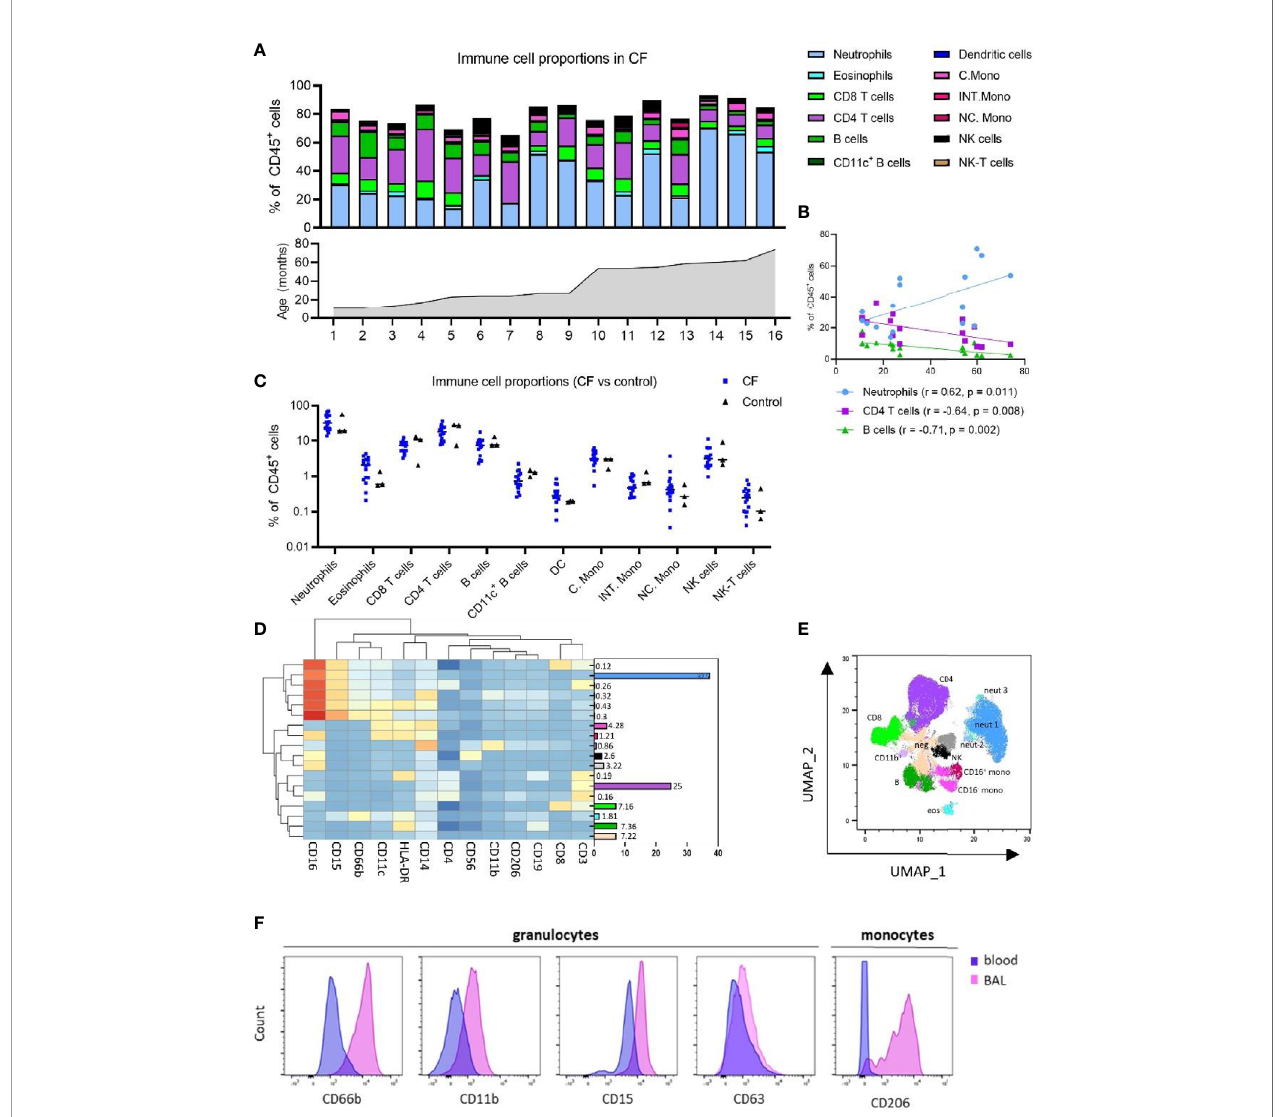
FIGURE 2 | Immune cell and in fl ammatory cytokine pro fi le of early life blood samples from children with cystic fi brosis (CF) and healthy controls. (A) Frequencies of peripheral blood immune cell subpopulations expressed as percentage of CD45 + leukocytes and in ascending order of age in children with CF (n = 16). (B) Two- sided spearman correlation analysis of circulating neutrophils, CD4 T cells and B cells with age in children with CF. (C) Frequencies of immune cell subpopulations in peripheral blood of children with CF (n = 16) and healthy controls (n = 3). (D) FlowSOM clustering of blood using 13 lineage markers revealed 18 cell clusters which have been annotated based on expression pattern and projected onto a (E) UMAP plot with colours corresponding to the annotated FlowSOM clusters. (F) Expression pro fi les of granulocytes and CD16 + monocytes in BAL and blood for activation and migratory markers CD66b, CD11b, CD15, CD63 and